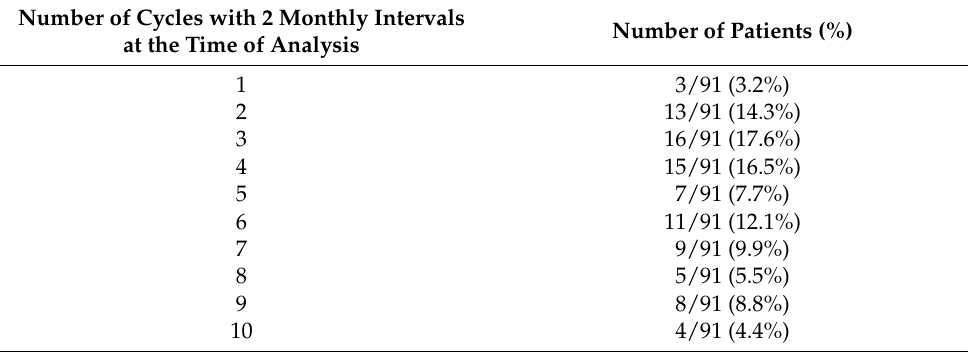
Table 5. Number of [ 225 Ac]Ac–DOTATATE cycles assessed by patients. Number of Cycles with 2 Monthly Intervals